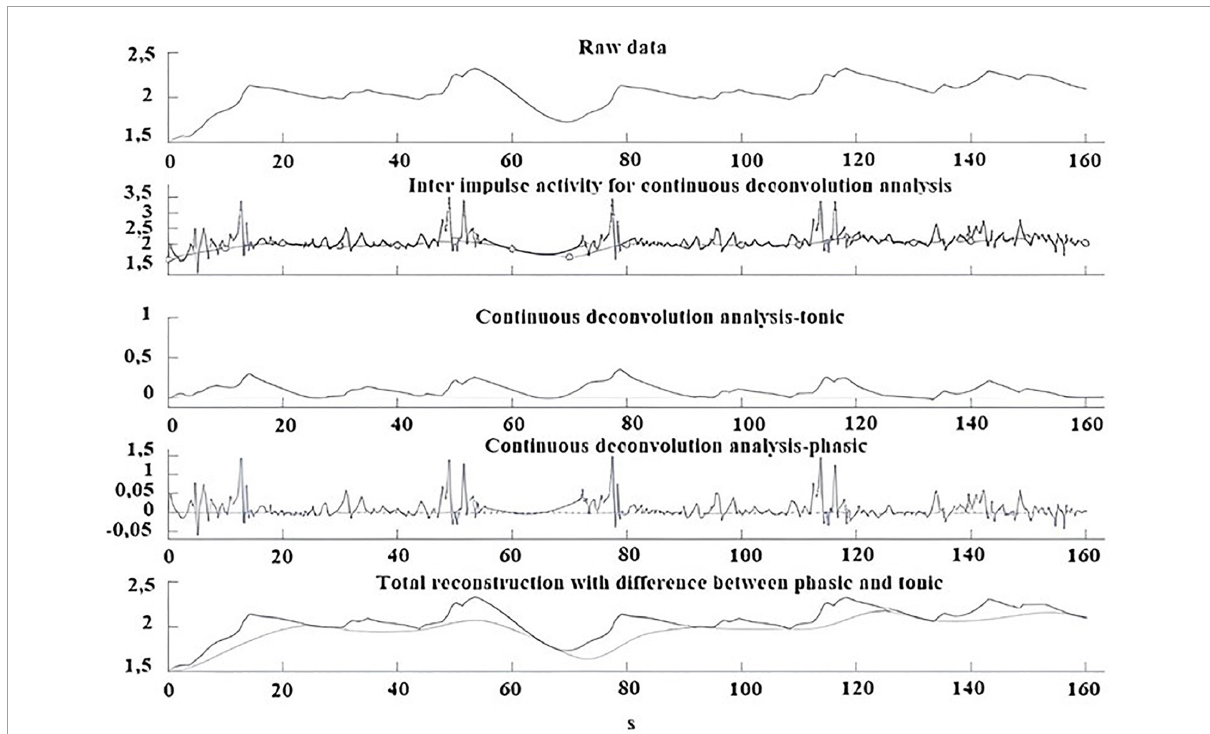
FIGURE5 Example of GSC analysis performed during the trigger sounds protocol in a participant with misophonia. From top to bottom: Skin conductance raw data; Inter impulse activity used for continuous deconvolution analysis; Continuous deconvolution analysis-tonic; Continuous deconvolution analysis-phasic; Total reconstruction with differences between phasic and